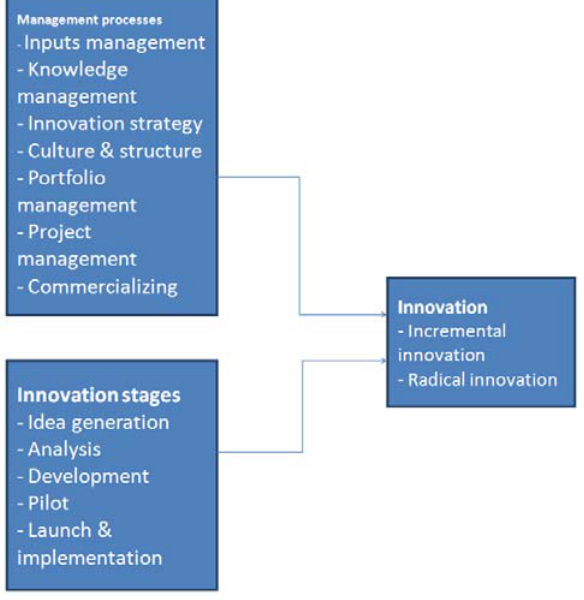
Fig. 1. Stages and management